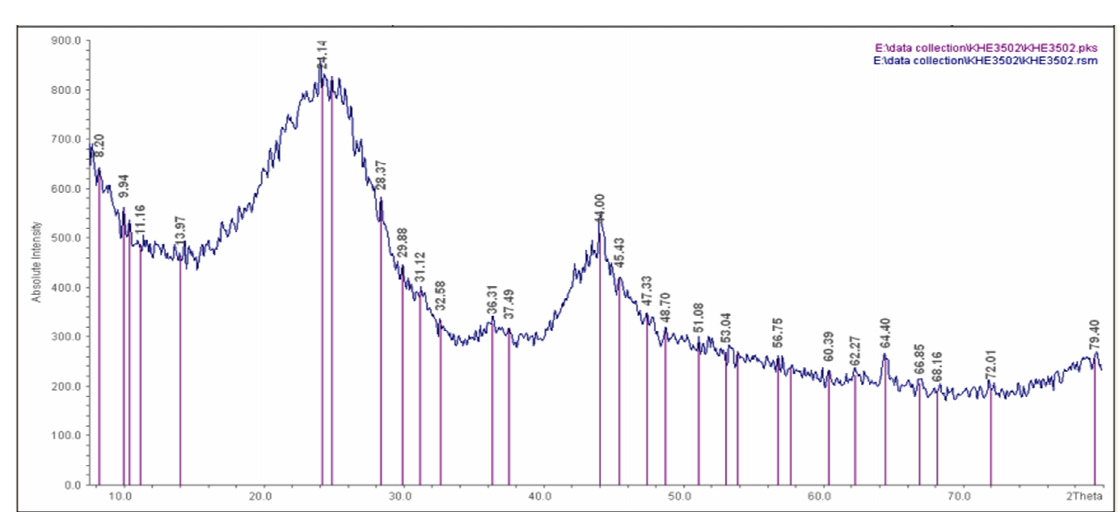
Figure 3. X-ray diffraction (XRD) patterns of activated carbon (AC) Table 1. Box–Behnken factorial design (BBD) matrix in coded terms along with experimental and predicted values for humic acid (HA)